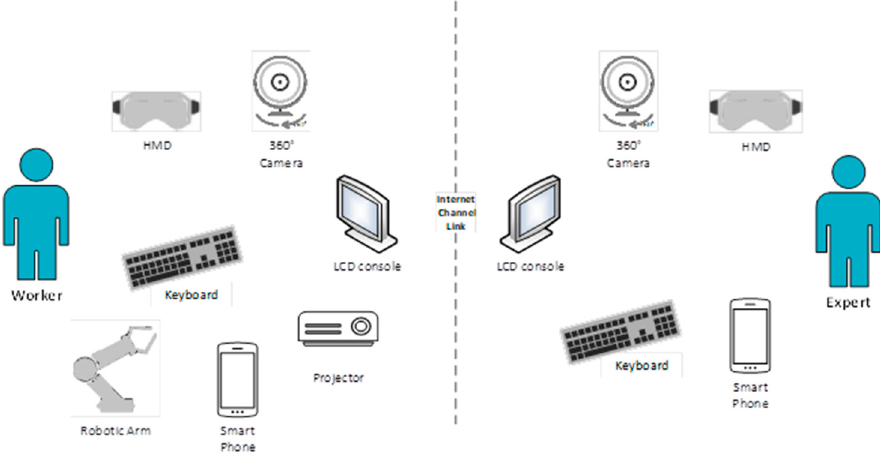
Figure 1. Worker side and remote expert side with devices enabling remote collaboration.